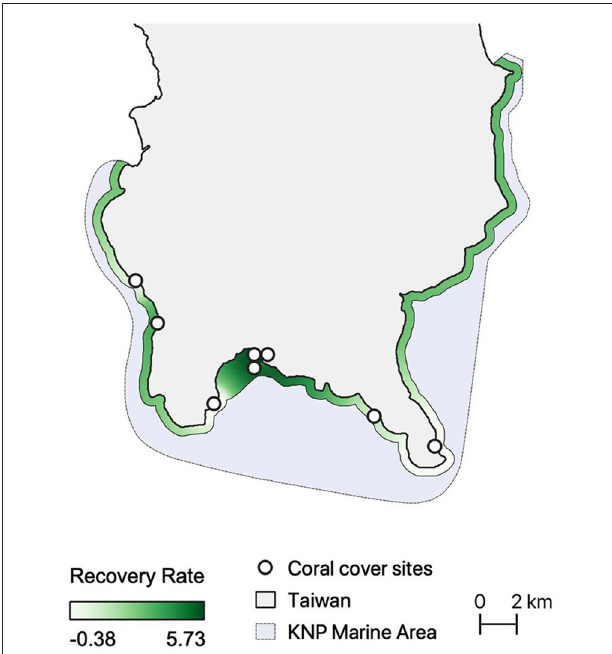
FIGURE 3 | Spatial Interpolation of coral cover recovery rate (2010 vs. 2016) along a 500-m coastal buffer. The white points indicate the sites monitored by the Long-Term Ecological Research (LTER) project in Kenting National